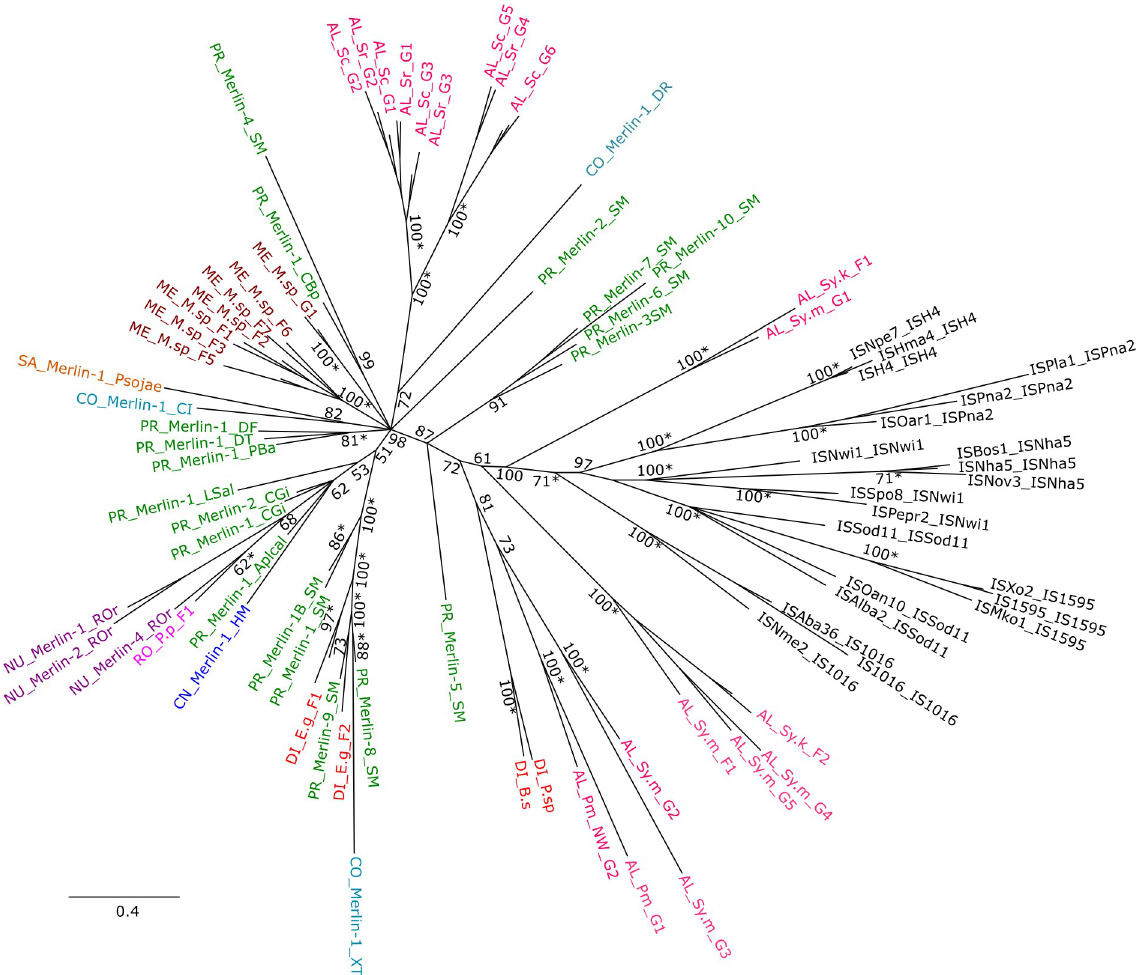
Fig 6. Unrooted 50% majority rule consensus Bayesian tree (WAG + G) of Merlin and IS 1595 group sequences based on the amino acid sequence of the conserved transposase domain DDE_Tnp_IS1595 (168 positions). Posterior probability values (PP) are indicated near the nodes and some of the values from derived clades were omitted. The � sign near PP values indicates the clade was supported with bootstrap higher than 50 in the ML tree. Merlin sequences from different taxonomic groups are highlighted in different colors and identified with initials: AL–Alveolata, CN–Cnidaria, CO–Chordata, NU–Nucletmycea, PR–Protostomia, SA–Stramenopiles, RO–Rhodophyceae, ME–Metamonada, DI–Discoba. Information of Repbase Merlin and IS 1595 sequences are found in S1 and S2 Tables, respectively. Merlin sequences